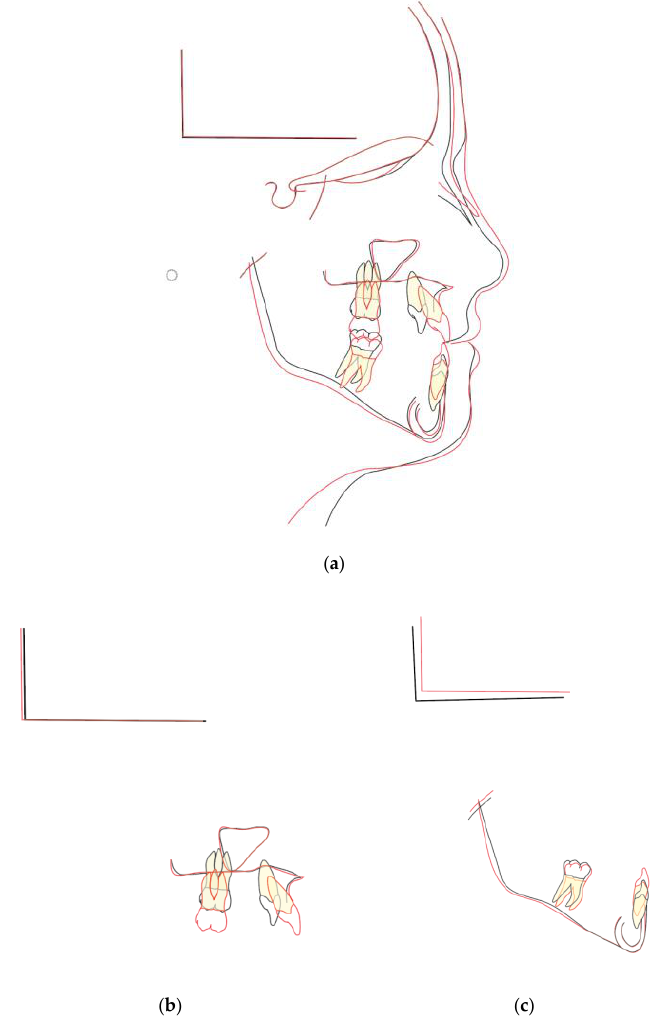
Commented [M3]: Figure 8 分为 abc 子图， 添 加 abc 符号